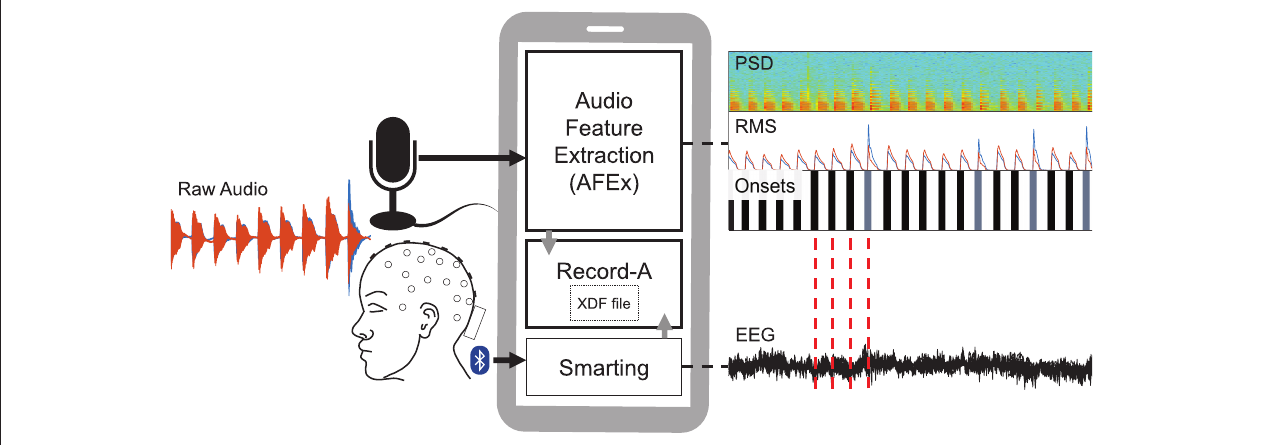
FIGURE 1 | Schematic of recording setup. The participant was equipped with a mobile EEG and listened to audio. An EEG data stream was generated by the Smarting app that received the data from the amplifier via Bluetooth. The sound features (PSD, RMS, onsets) were computed by the AFEx app which received the